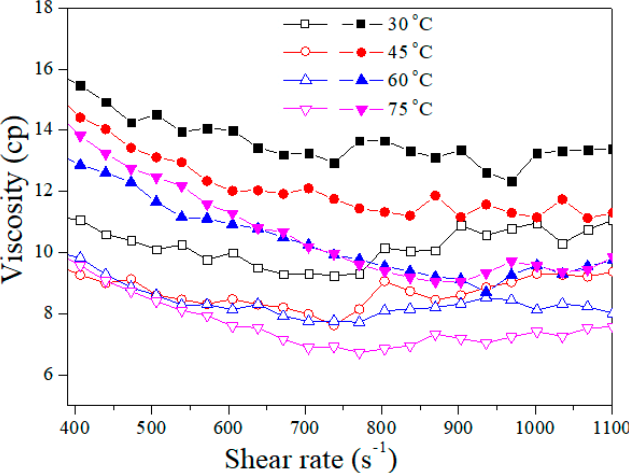
Figure 5. Shear viscosity of Flopaam 3630S solution at 1500 ppm (closed) and 1000 ppm (open) at different temperatures.